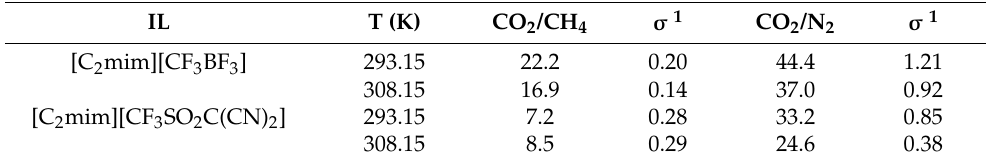
Table 5. CO 2 ideal permselectivities ( α ) of the [C 2 mim][CF 3 BF 3 ] and [C 2 mim][CF 3 SO 2 C(CN) 2 ] ILs in SILM configuration at 293.15 K and 308.15